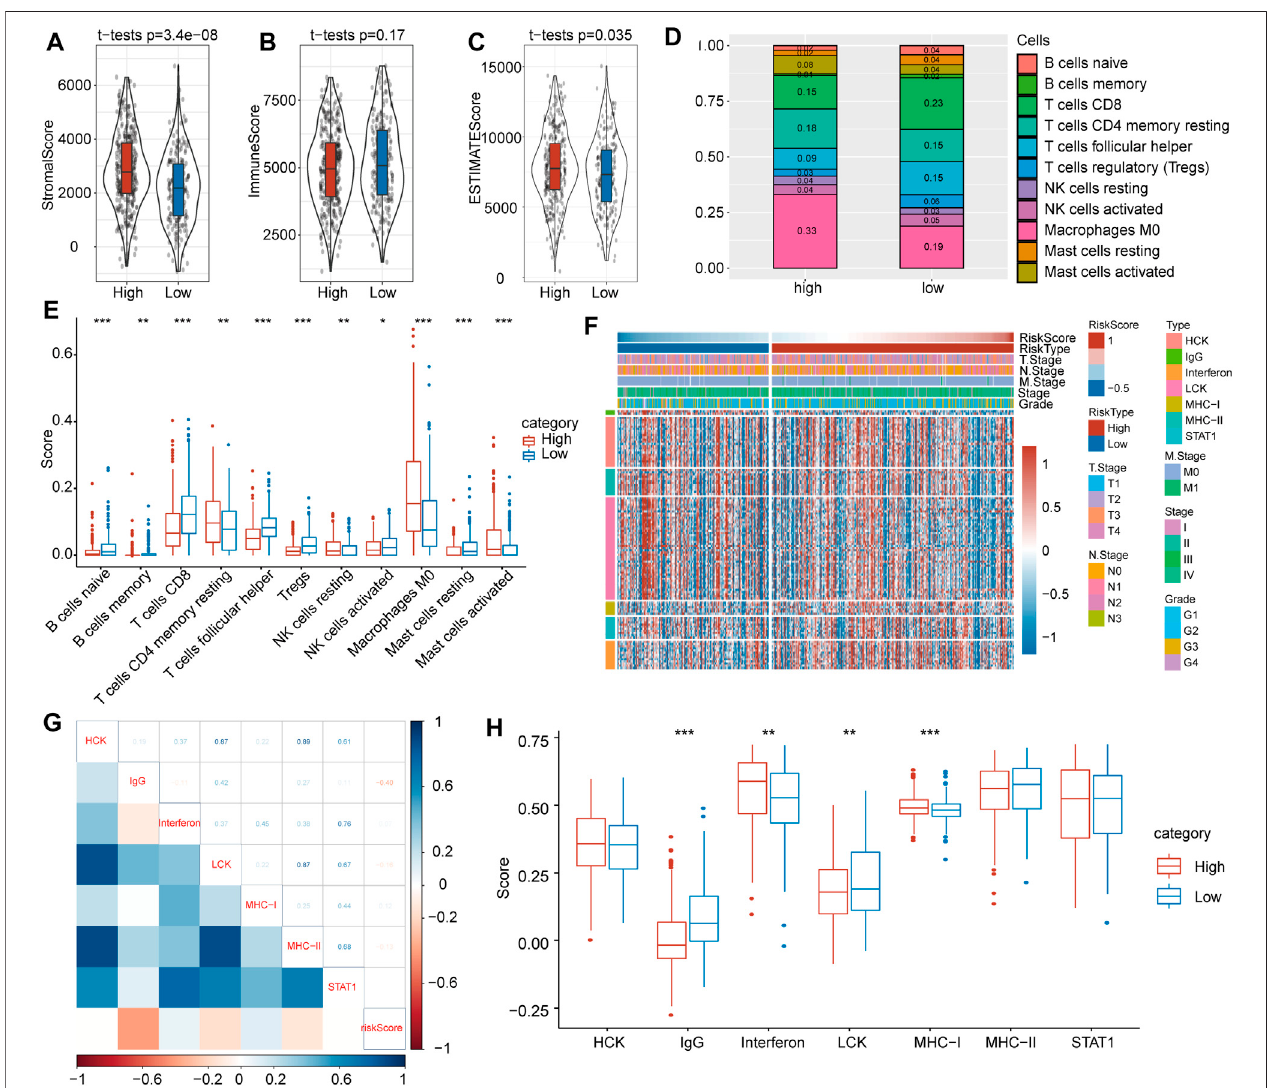
FIGURE 6 | Immune-associated evaluations between high- and low-risk score subgroups. (A) The stromal score was greatly higher in the high-risk score subgroup. (B) There was no signi fi cant difference in immune score between the high- and low-risk subgroups. (C) The immune score was markedly higher in the high- risk score subgroup. (D) The immune cell distribution in the high- and low-risk subgroups. (E) Comparisons of involved immune cells between the two subgroups. (F) Heat map landscape of clinical feature distribution in the high- and low-risk score subgroups. (G) Correlations between ssGSEA scores of seven immune- associated genes. (H) Score comparisons of immune-associated genes between the high- and low-risk